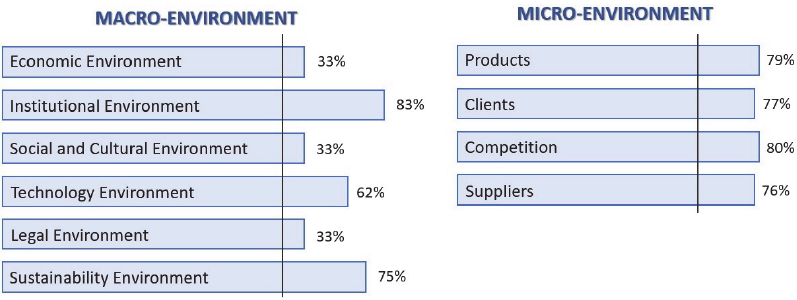
Figure 7. Scoring of macro and micro environment sub elements. Source: own elaboration.